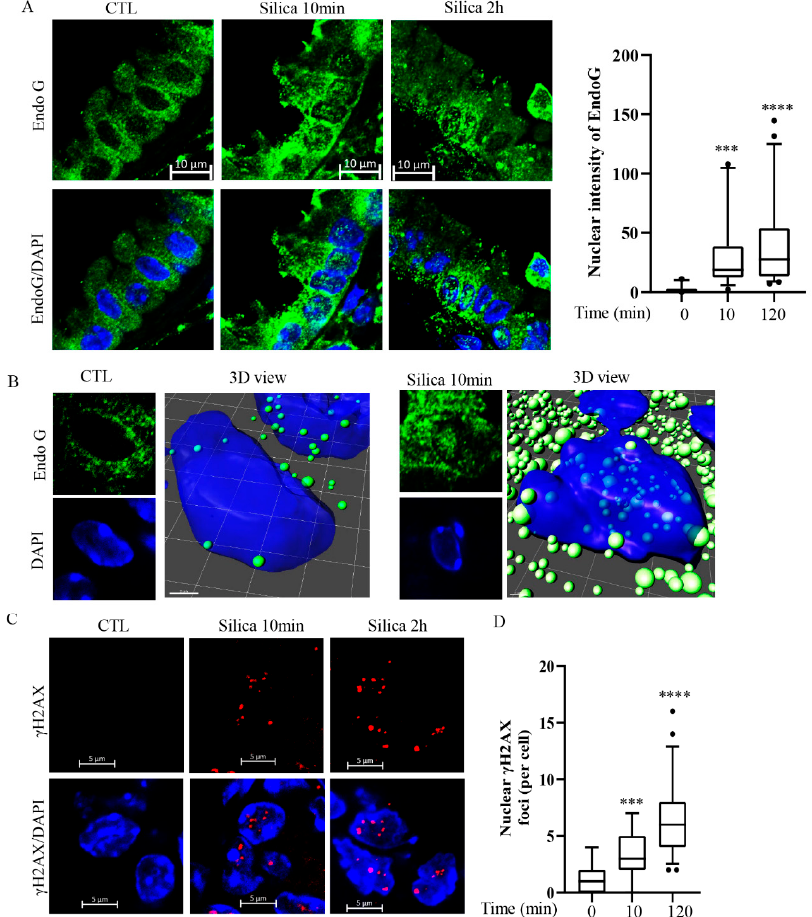
Figure 2. Silica-induced nuclear translocation of EndoG in mouse lung in vivo. Mice were exposed to a single dose of silica (25 μ g/mouse) or to PBS as control (CTL) by nasal instillation. In ( A ), repre- sentative confocal images showing EndoG (green) and nuclear (blue) staining in mouse lung sec- tions. Nuclear EndoG was quantified by ImageJ software. In ( B ), images from A using Z-stack were analyzed as 3D view by Imaris software. In ( C ) representative confocal images showing γ H2AX (red) and nuclear (blue) staining in mouse lung sections. Nuclear γ H2AX foci was quantified by ImageJ software ( D ). Bars show median with 95% confidence interval. All experiments were per- formed at least in triplicate. *** p < 0.001, **** p < 0.0001 compared to PBS, as determined by ANOVA